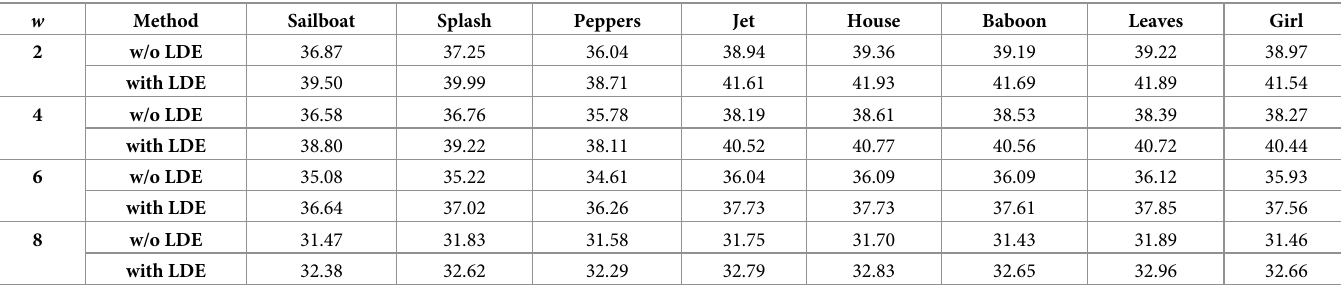
Table 3. PSNR comparisons with and without the LDE technique.